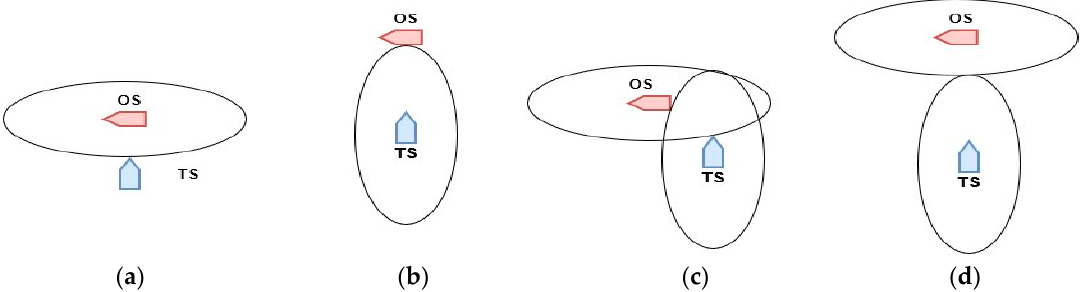
Figure 2. Different safety criterion of ship safety domain: ( a ) Own-Ship (OS) domain is not violated; ( b ) Target-Ship (TS) domain is not violated; ( c ) neither OS nor TS domain is violated, and ( d ) both domains do not overlap.